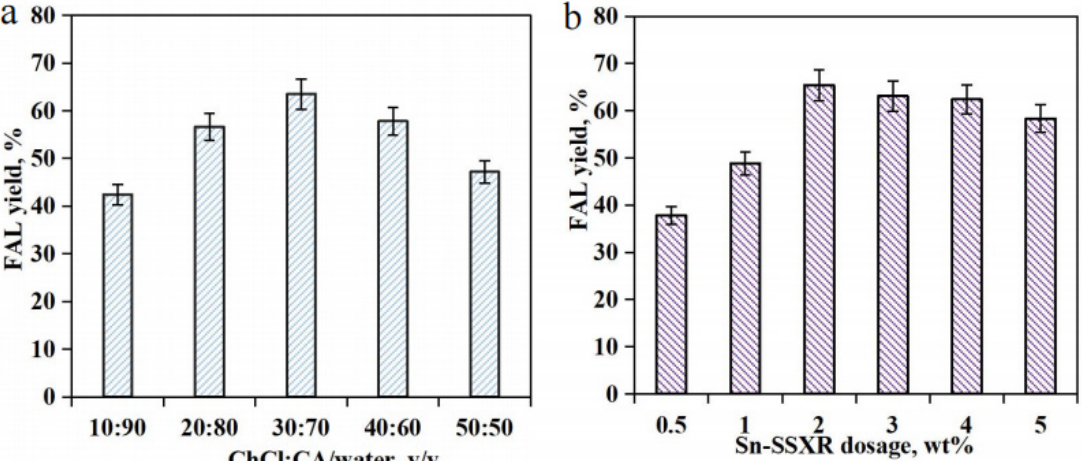
Figure 1. Effects of ChCl:LA loading (0–50 vol%) on the FAL yield (corncob 75 g/L, Sn-SSXR 2 wt%, 180 °C, 15 min) ( a ); Effects of Sn-SSXR dosage (0.5–5 wt%) on the FAL production in ChCl:LA–water (30:70, v / v ) (corncob 75 g/L, 180 °C, 15 min) ( b ). The catalytic temperature (160, 170, 180, and 190 °C) and catalytic duration (5–50 min) had a profound influence on the formation of FAL (Figure 2). Lower catalytic reaction temperature might not provide enough energy to dehydrate xylose into FAL by using Sn- SSXR as a catalyst. While a higher performance temperature might accelerate the FAL degradation, resulting in a decreased FAL yield due to the formation of undesirable by- products [37]. The highest FAL yield reached 65.4% by using corncob (75.0 g/L) as feed- stock in the presence of Sn-SSXR (2.0 wt%) as a chemocatalyst in ChCl:LA–water (30:70, v / v ; 180 °C) for 15 min. The formed FAL liquor contained FAL (126.3 mM), 5-HMF (3.1 mM), formic acid (130.4 mM) glucose (13.7 mM), D -xylose (31.2 mM), arabinose (3.6 mM), and levulinic acid (0.92 mM).